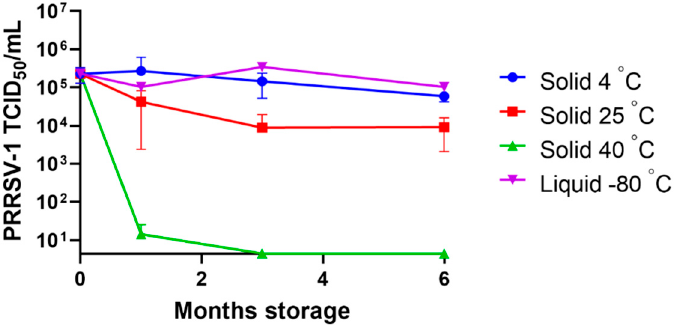
Figure 5. Assessment of the stability of a unit solid dose injectable vaccine formulation of PRRSV MLV. A USDI formulation of PRRSV-1 Olot/91 was stored at 4 ◦ C, 25 ◦ C or 40 ◦ C for 1, 3, and 6 months. At these timepoints, solid doses were reconstituted in DMEM, adjusted to a predicted titre of 1 × 10 5 TCID 50 /mL and titrated on MARC-145 cells. Untreated PRRSV-1 stored at − 80 ◦ C (liquid − 80 ◦ C) served as a positive control. Mean data are presented for duplicate or triplicate samples ± SD.